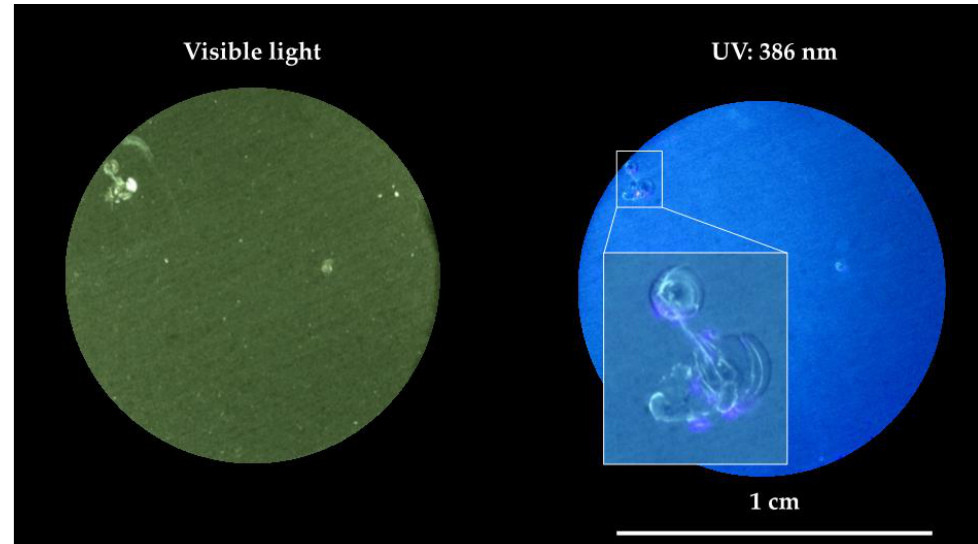
Figure 6. Optical microscope images of the surface of damaged co-PPM 9% coatings after 60 days of exposure to NaCl water solution.